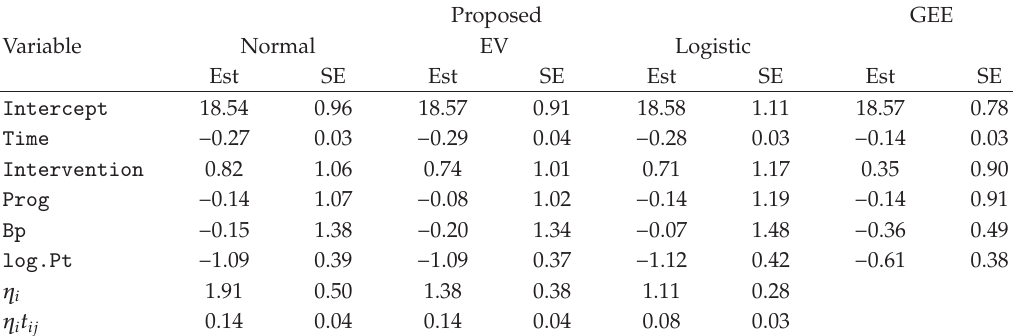
Table 4: Estimates of regression coe ffi cients for the MDRD